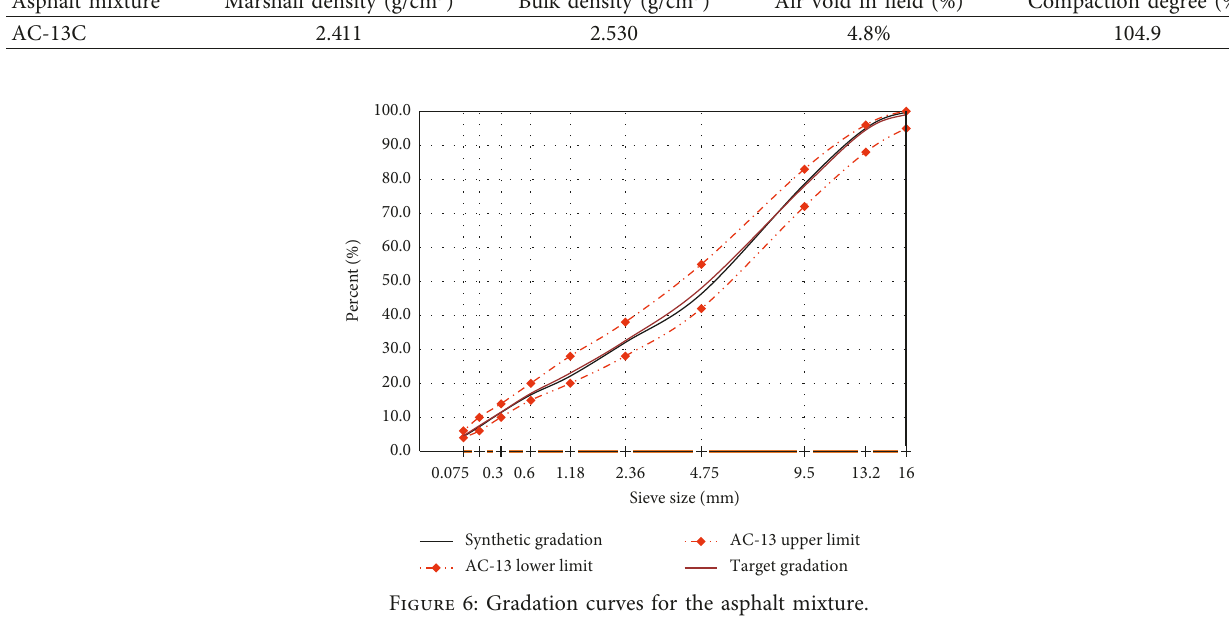
Figure 6: Gradation curves for the asphalt mixture.